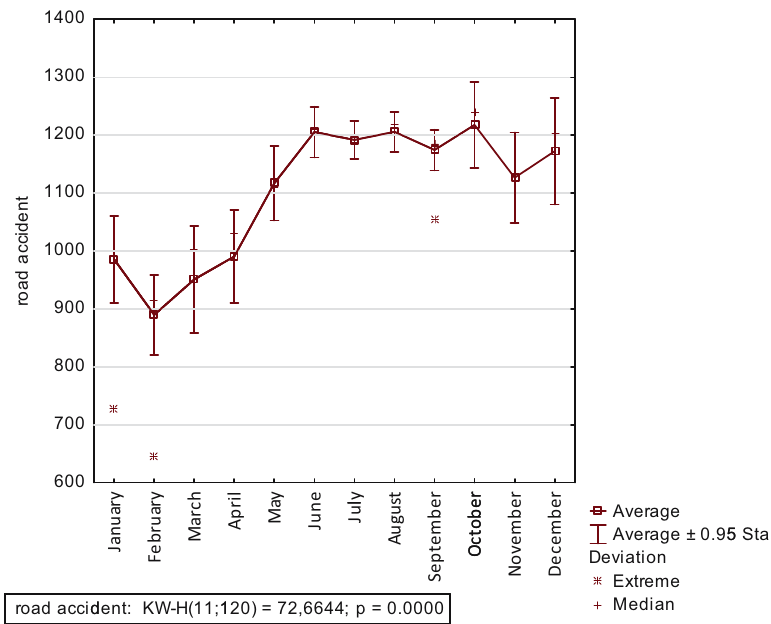
Figure 3: Comparison of the mean number of road accidents in Slovakia by month over the years 2000 –